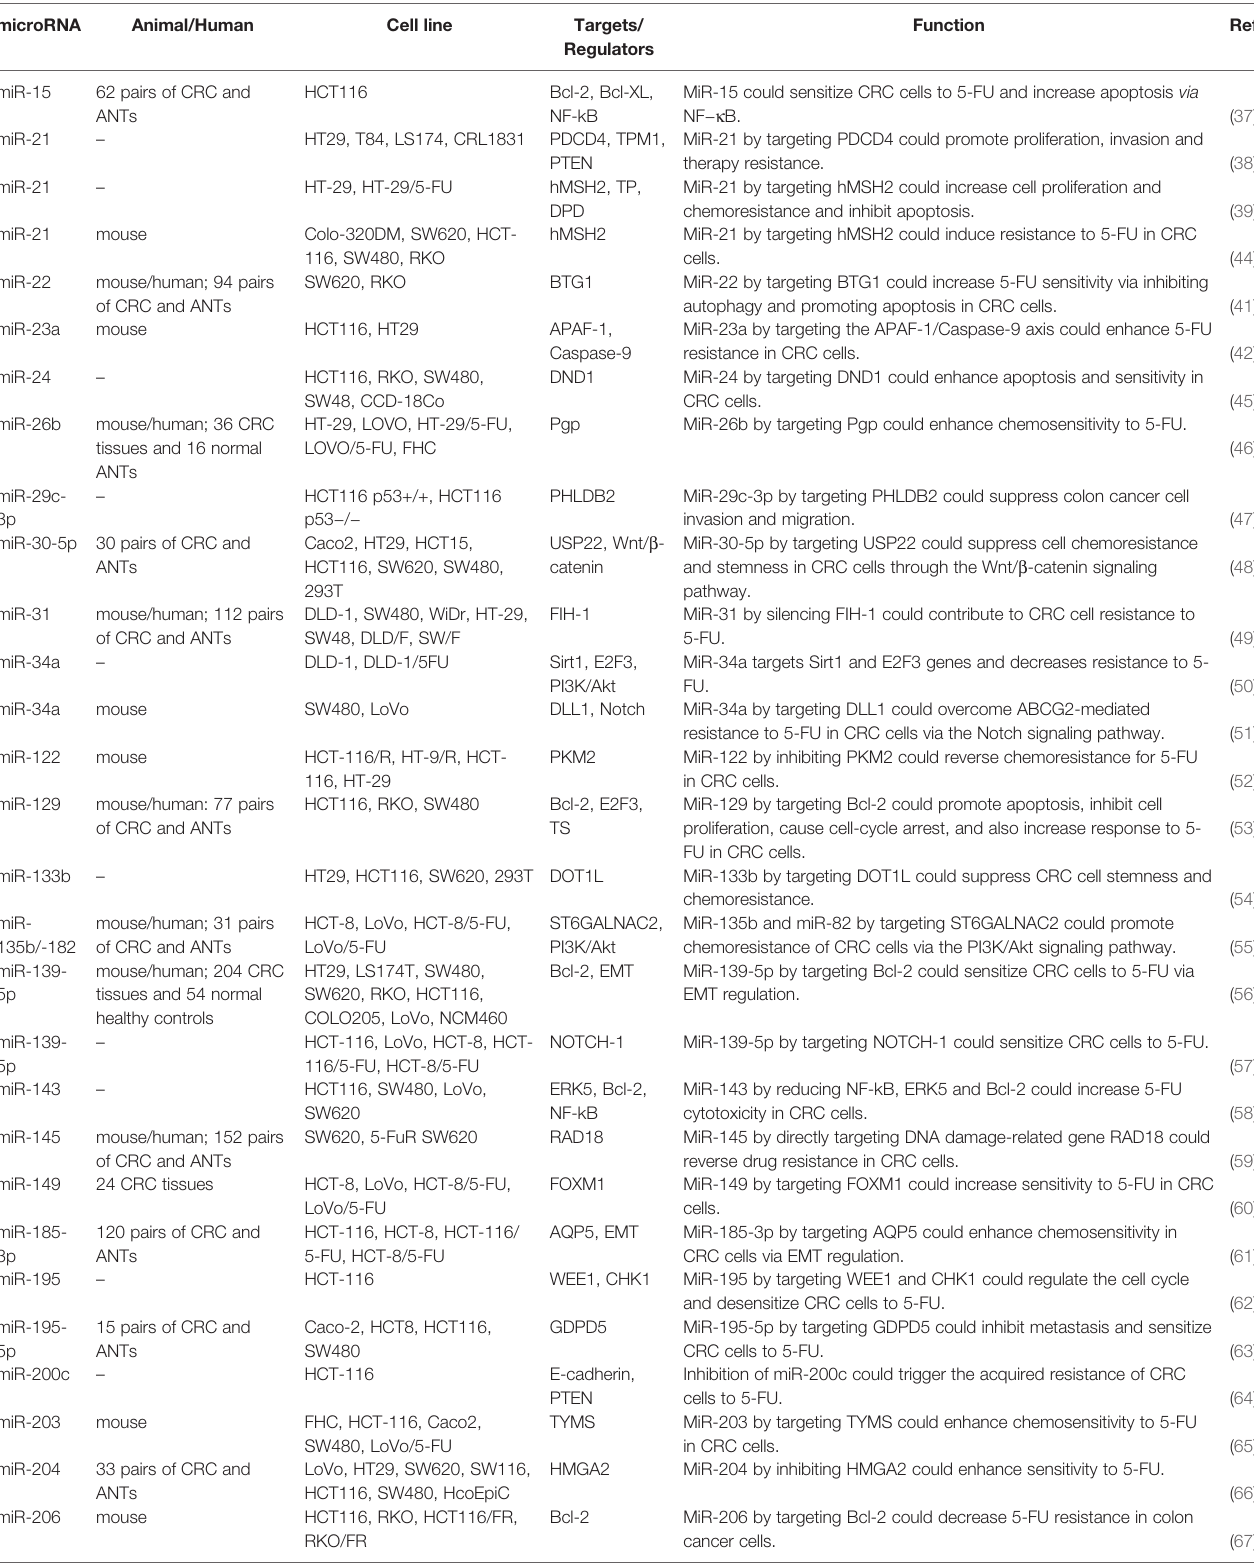
TABLE 1 | Role of miRNAs in the modulation of response to 5-FU in colorectal cancer (ANT, adjacent normal tissue).